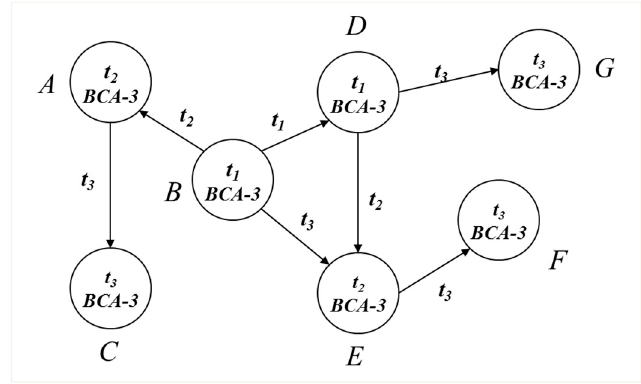
Figure 4. Combination of BCA-3.